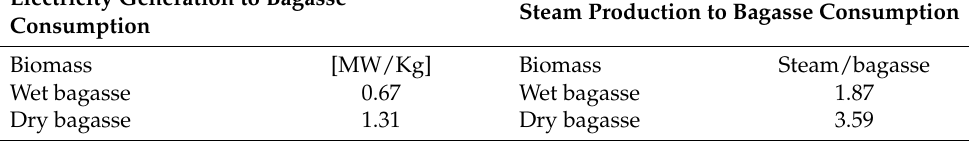
Table 5. Impact of moisture content in energy requirement for electricity generation and steam production in annual